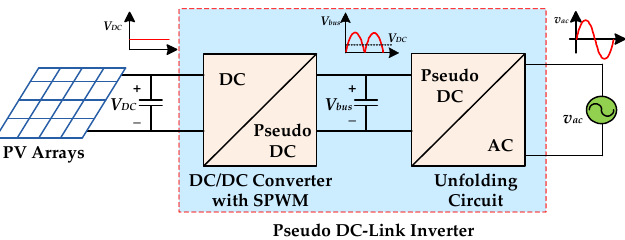
Figure 2. The grid-connected PV power system with a pseudo DC-link inverter.